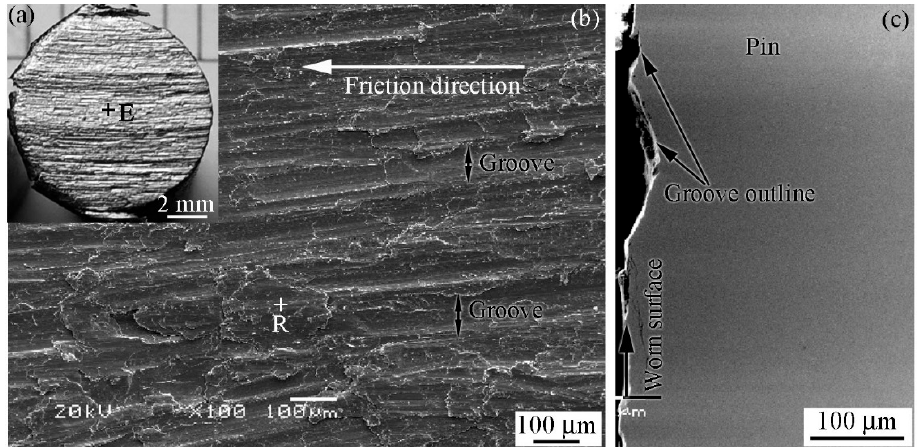
Figure 8 Features of the pin worn surface when the RD was used during the friction process; H = 26.1 × 10 3 A/m. ( a ) Macro-photograph, ( b ) SEM image of the worn surface, and ( c ) SEM image of the cross section.